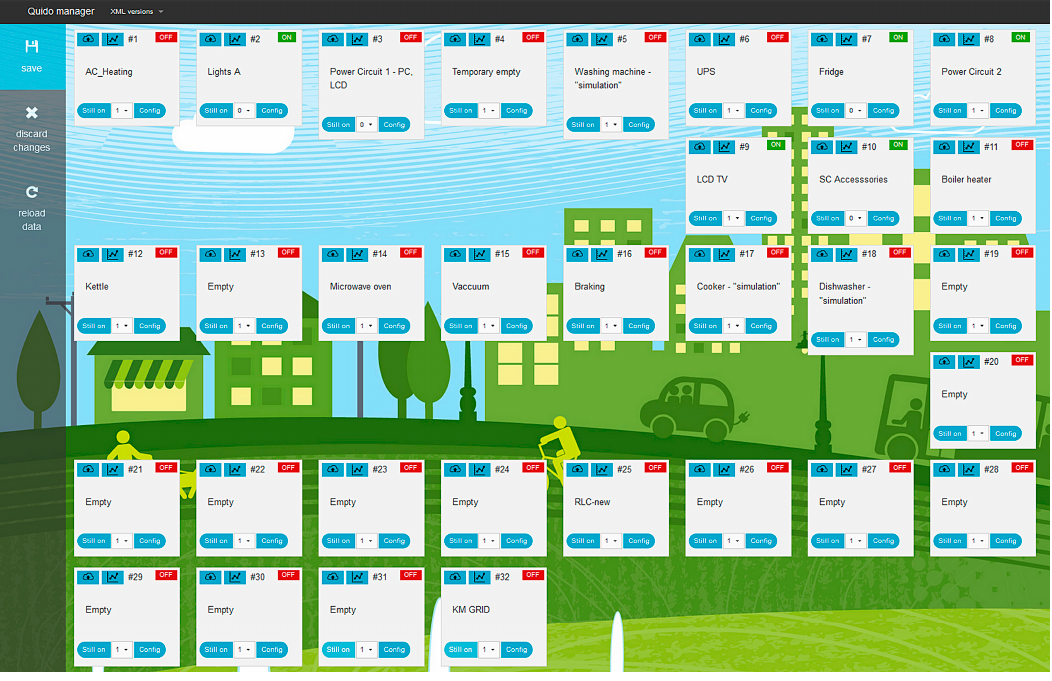
Figure 10. The web page generated by the control system, visualizing home appliances actual states.